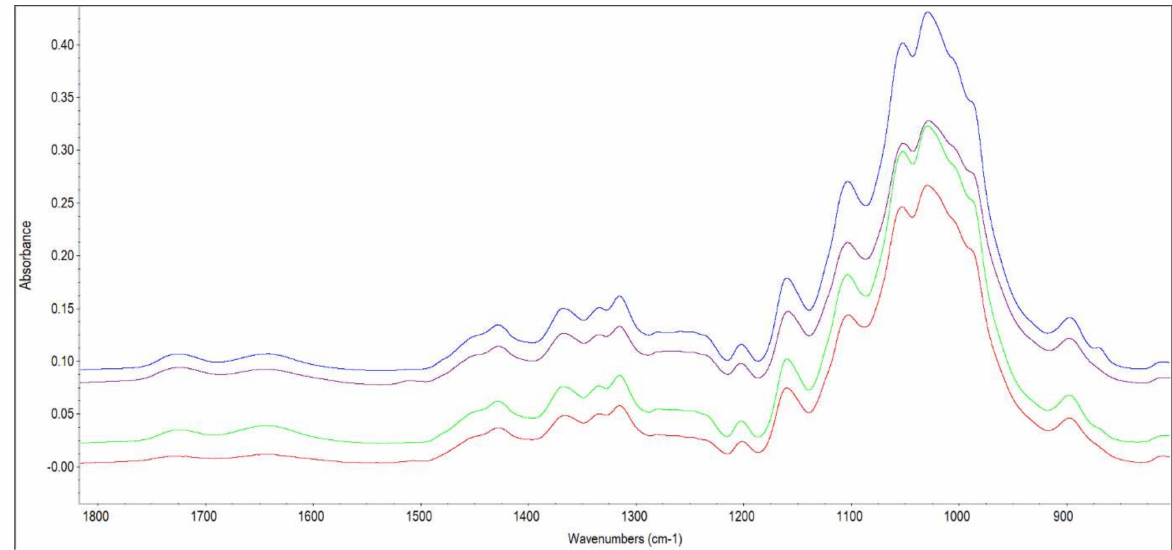
Figure 11. FTIR spectrum of cellulose isolated from wood before and after its 2-, 4- and 6- month-long storage (Note: blue line-December 0, magenta line-February, green line-April, red